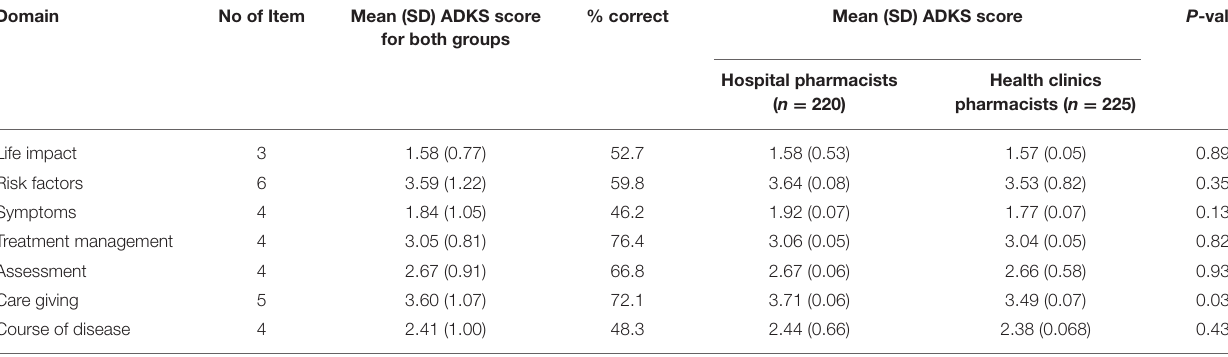
TABLE 2 | ADKS content domain scores between public hospitals and health clinics pharmacists.